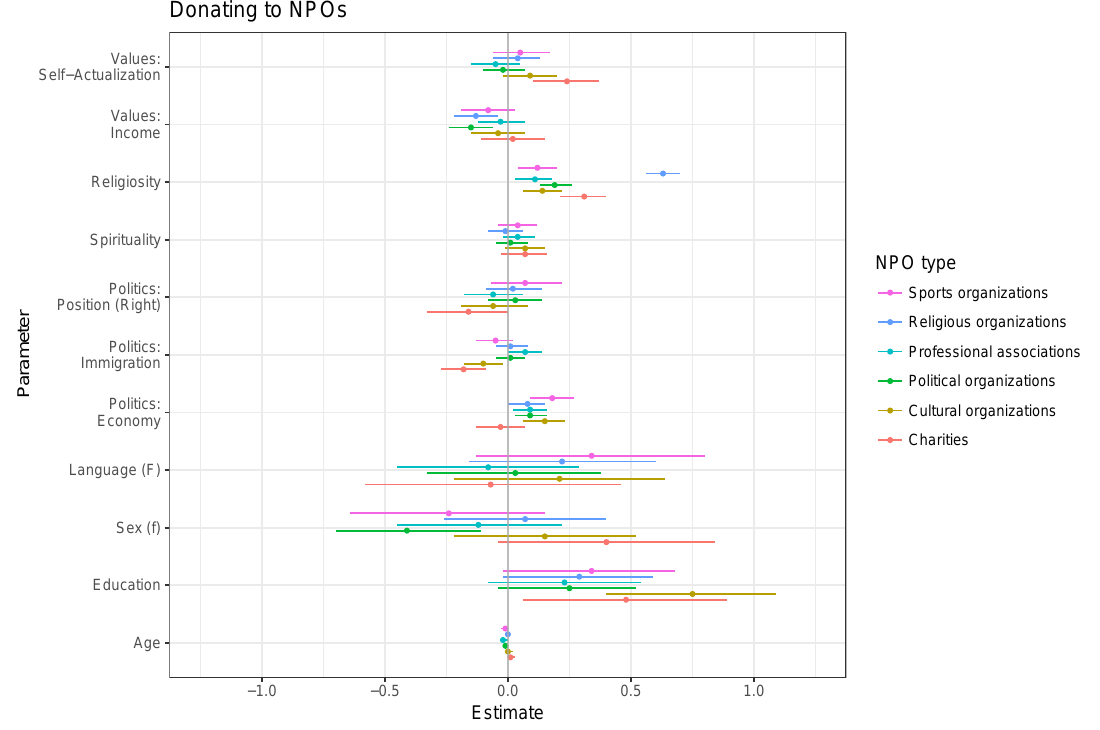
Figure 3. Parameter estimates for the six models with donation intention as the response (dependent)